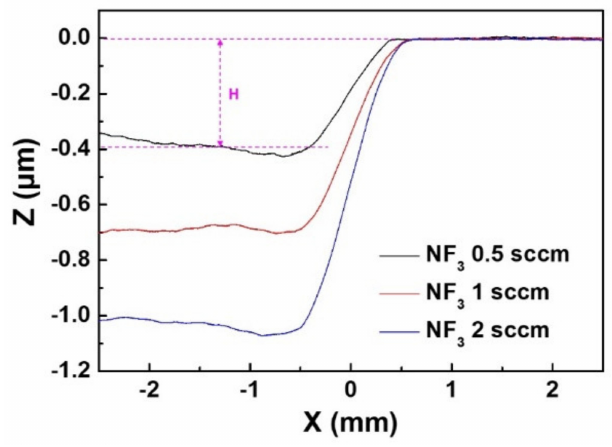
Figure 6. Etch profiles of the specimens etched by the mixed gas filament plasma of He 2 slm and NF 3 0.5, 1, and 2 sccm (black, red and blue, respectively) of 6 mm by 6 mm raster scan etch (H: etch